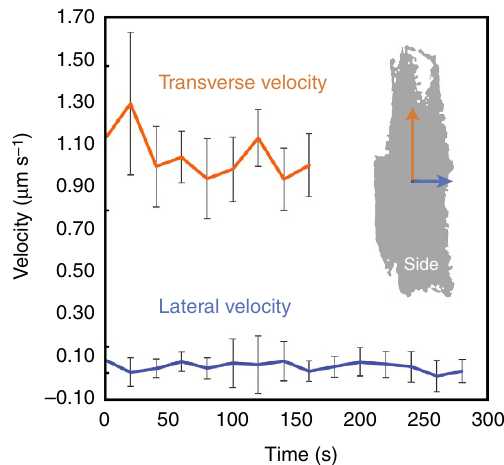
Figure 4 | Interfacial velocities of the eutectic colony during solidification. Measured are the growth rates in the transverse and lateral directions, as indicated by the arrows on the side (90 (cid:2) ) silhouette of the colony (see inset). Throughout the growth process, the colony evolves roughly ten times more rapidly in the transverse direction compared to the lateral. The colony extends very slowly in the lateral direction due to the sluggish kinetics of the untwinned {111} lamellae at early times and the bulbs of Al impeding growth at later times. In the transverse direction, the Ge flakes precede the metal and are able to grow unhindered. Error bars represent one s.d., with five measurements.